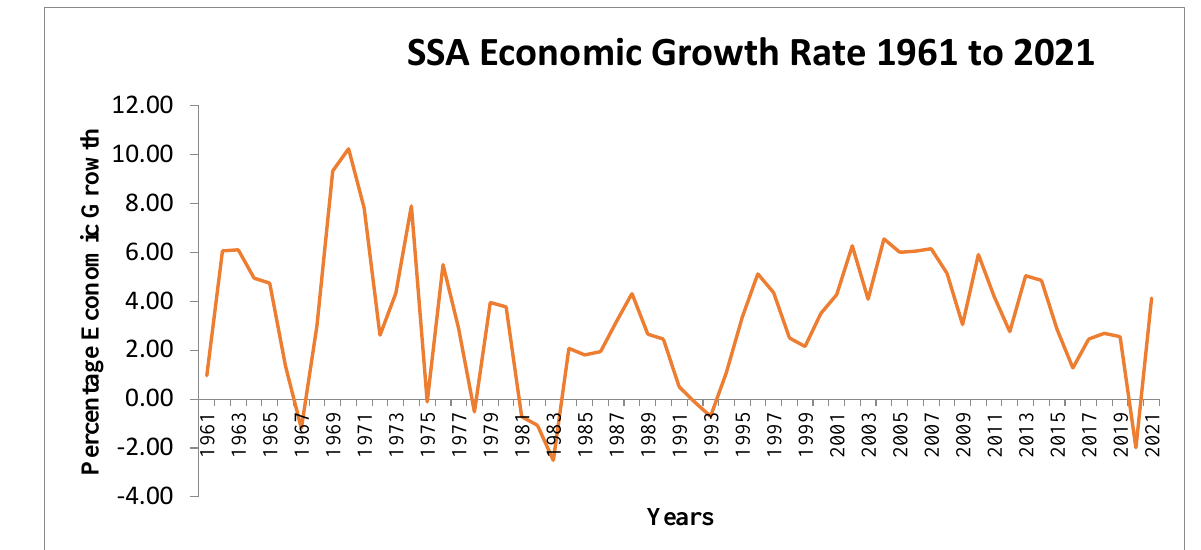
Figure 7. Sub-Saharan African economic growth rates over time. Source: Macrotrends, 2022. Current projections indicate that many countries’ GDP per capita will not recover to pre-crisis levels until 2025 [10]. Expectations are that the growth gap between Sub-Saharan Africa and the rest of the world will worsen during the next five years. Sub-Saharan Africa is forecast to see a slower economic recovery than the rest of the world, with cumulative per capita GDP growth for the 2020–2025 period predicted at 3.6%. This is significantly lower than the projected growth rate for the rest of the world (14%) [58].